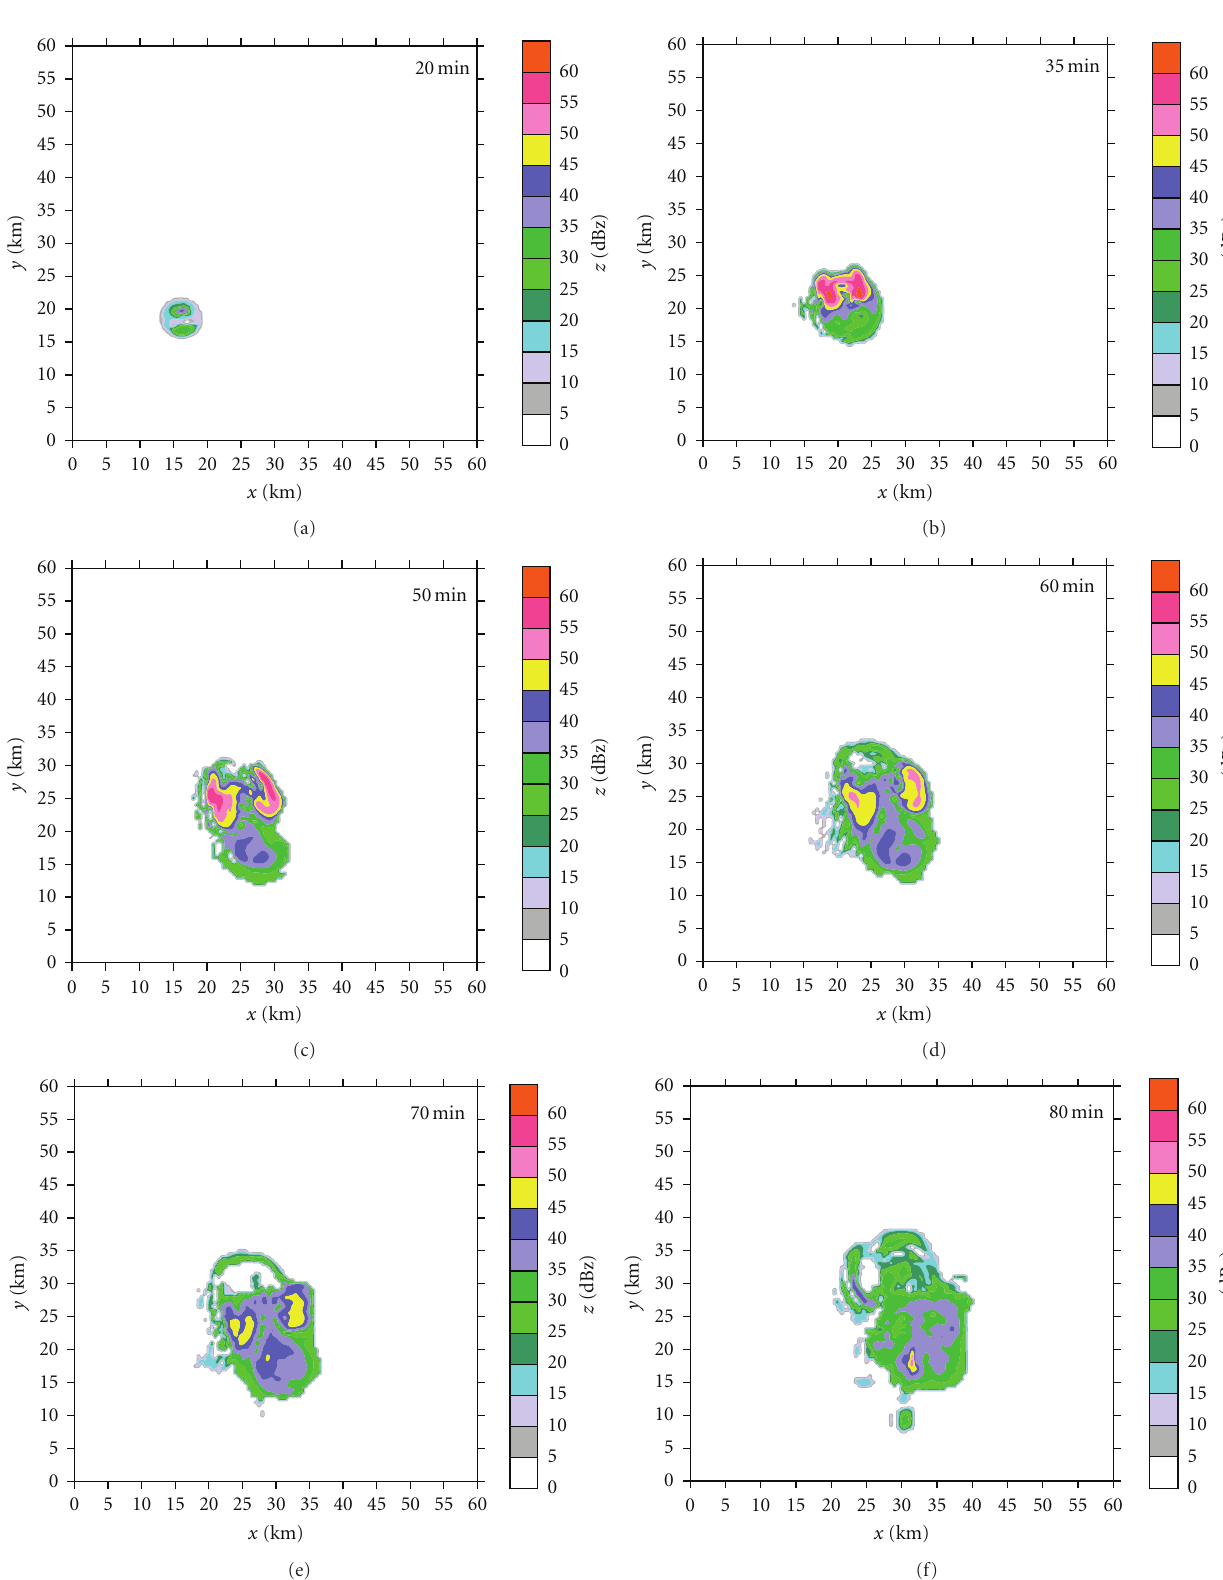
Figure 9: The same as Figure 8, except for using a finer resolution of the model. Model run